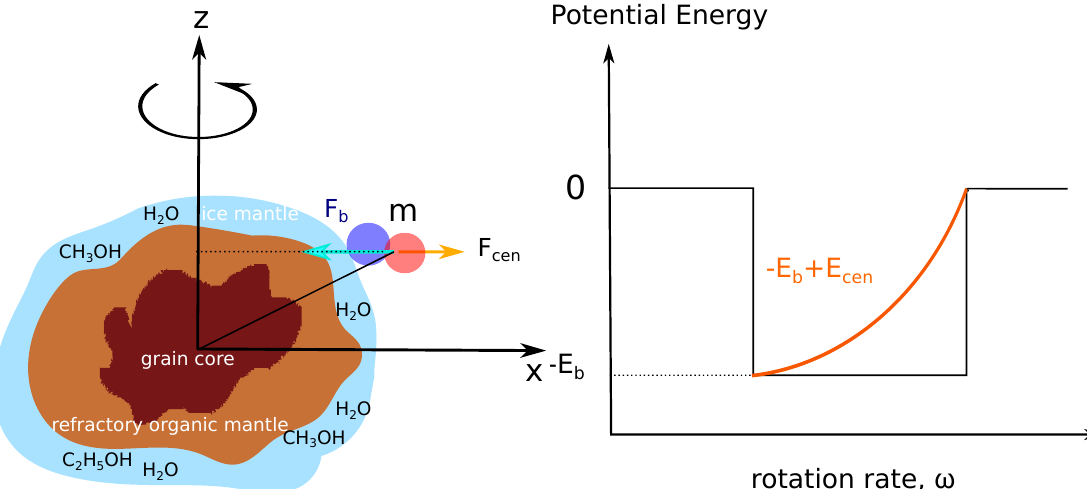
Figure 9. Left panel: Illustration of a spinning dust grain with ice mantle. A molecule on the surface experiences binding force and centrifugal force in opposite directions. Right panel: Illustration of the potential energy of a molecule on the rotating grain. The potential barrier is reduced significantly as the angular velocity ω increases as a result of centrifugal potential ( E cen ). From Hoang and Tung